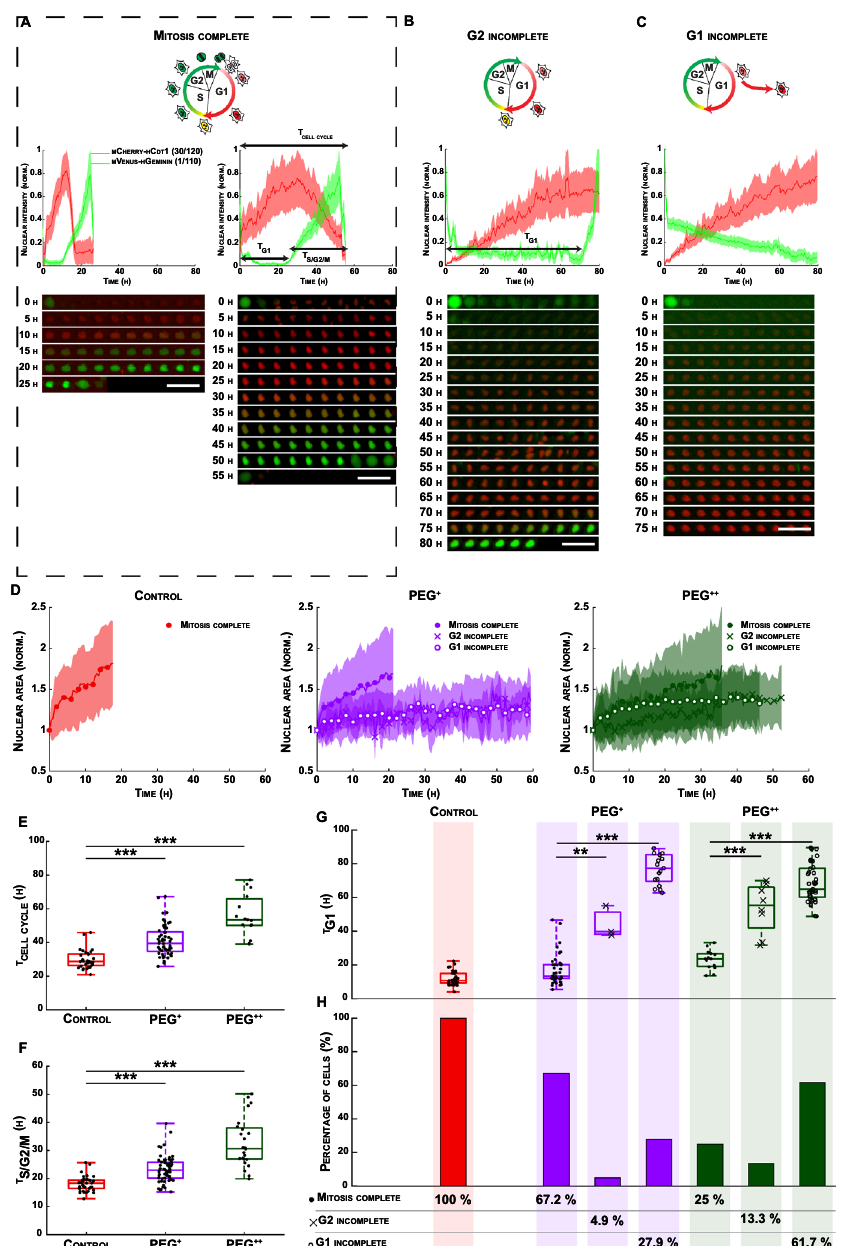
Figure 2. At a single cell level, increase in osmotic pressure leads to the emergence of distinct cell subpopulations with impaired nuclear growth and delayed or arrested cell cycle. ( A – C ) Normalized FUCCI2 fluorescence intensity inside of segmented nuclei (middle panels), corresponding fluorescence images over time (bottom panels) and cartoons (top panels) representing the cell cycle phases in three different cell subpopulation: ( A ) cell cycle with mitosis complete (“Mitosis complete”), ( B ) cell cycle with prolonged time in G1 until the cells start the S/G2/M phase (“G2 incomplete”) and ( C ) the cells remain in G1 for the whole duration of the experiment (“G1 incomplete”). The time 0 h for each single cell corresponds to the first frame after division of the parent cell. Scale bars are 100 µm. ( D ) Normalized nuclear area as a function of time for the three experimental groups and the three different cell subpopulations. The line is the average and the shaded area is the standard deviation. ( E ) Duration of the whole cell cycle (time from division to division) for the cell subpopulation “Mitosis complete” (N = 34, 57 and 15 cells for the control (red), PEG + (violet) and PEG ++ (green) groups). ( F ) Duration of the S/G2/M phase for the cell subpopulation “Mitosis complete” (N = 39, 61 and 24 cells for the control, PEG + and PEG ++ groups, respectively). ( G ) Duration of the G1 phase in the three different cell subpopulations: “Mitosis complete”, “G2 incomplete” and “G1 incomplete”, for the control, PEG + , PEG ++ , groups, respectively. ( H ) Fraction of cells in the three different cell subpopulations, for the groups: control, PEG + and PEG ++ . The plots represent the median, 1st and 3rd quartiles and extrema. Statistical analysis with respect to the control using a two-tailed Wilcoxon rank sum test, n.s: p > 0.05, *: p < 0.05, **: p < 0.01 and ***: p < 0.001. The FUCCI2 cartoons were adapted from Sakaue-Sawano et al. 22 , Copyright (2008), with permission from